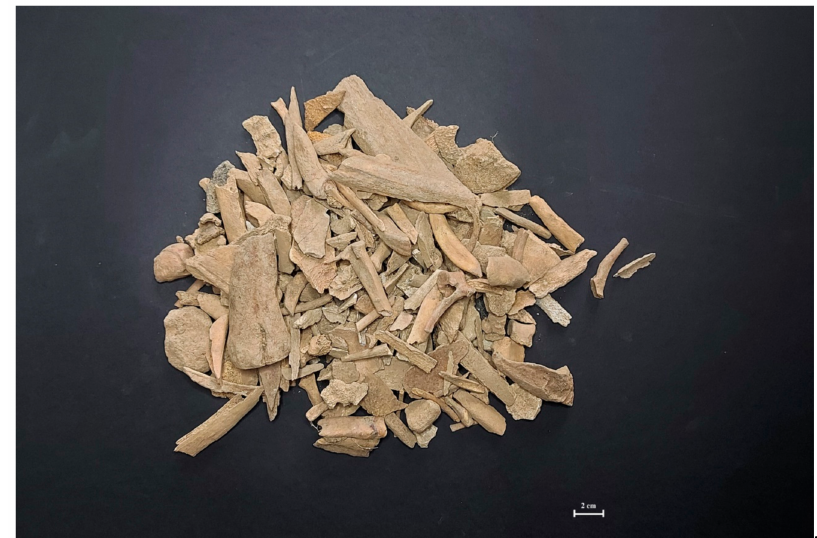
Figure 3. Typical of animal bone assemblage from Kamienna G ó ra site. Table 4. The osteometry of measurable dog and horse bone remains from Kamienna G ó ra with computed height at